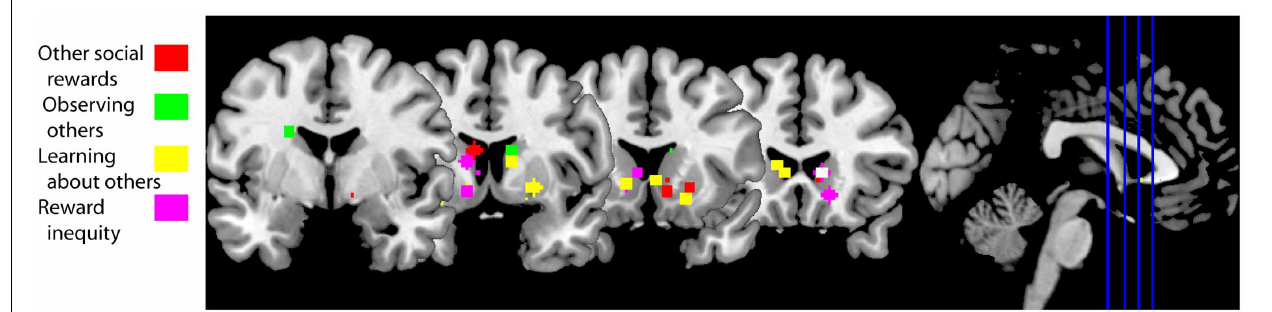
FIGURE 3 | fMRI studies of social behaviors in which the striatum is active. Peak activation coordinates in the striatum of the fMRI studies cited in this review color-coded for each section as illustrated in the legend. Studies using a region of interest analysis strategy were not included in this image. These striatal responses are compatible with a general activation in response to social behaviors, including social rewards. A functional subdivisions according to types of social rewards need to await further experiments. Studies aggregated in “Other social rewards”: